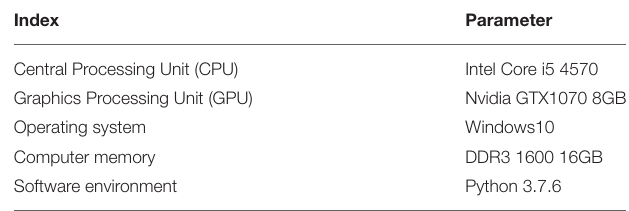
TABLE 4 | Computer configuration